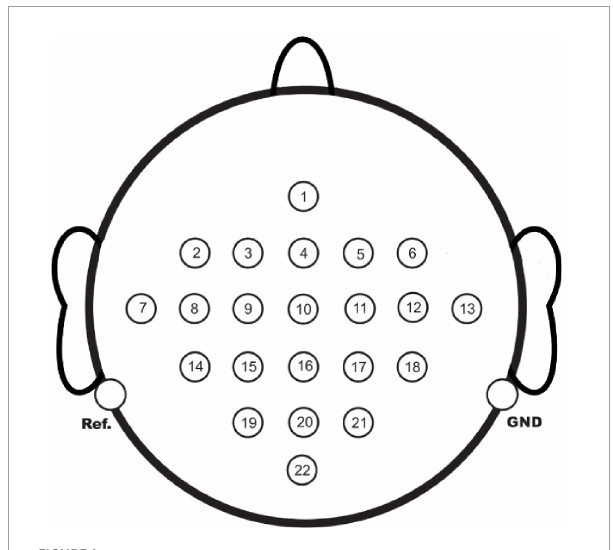
FIGURE1 Electrode arrangement of the data set, a total of 22 channels were